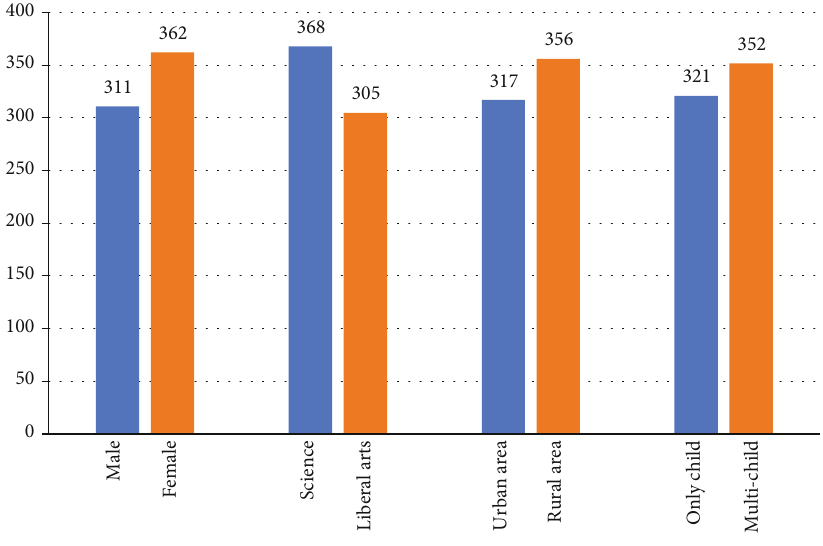
Figure 1: Distribution of respondents. Table 1: Scores of self-esteem, interpersonal trust, and social anxiety ( M ± SD ).